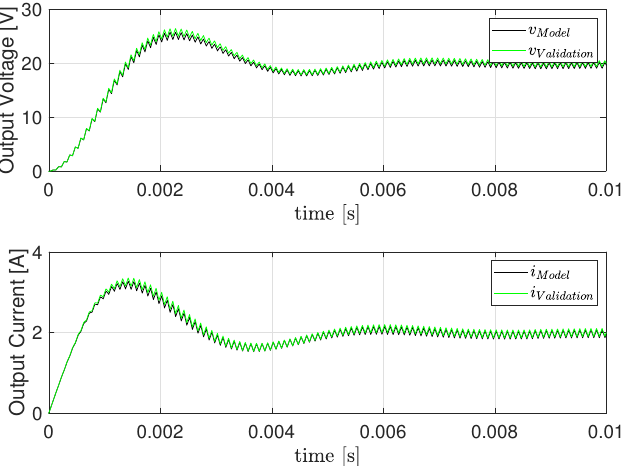
Figure 2. Validation of the mathematical model proposed in Equation